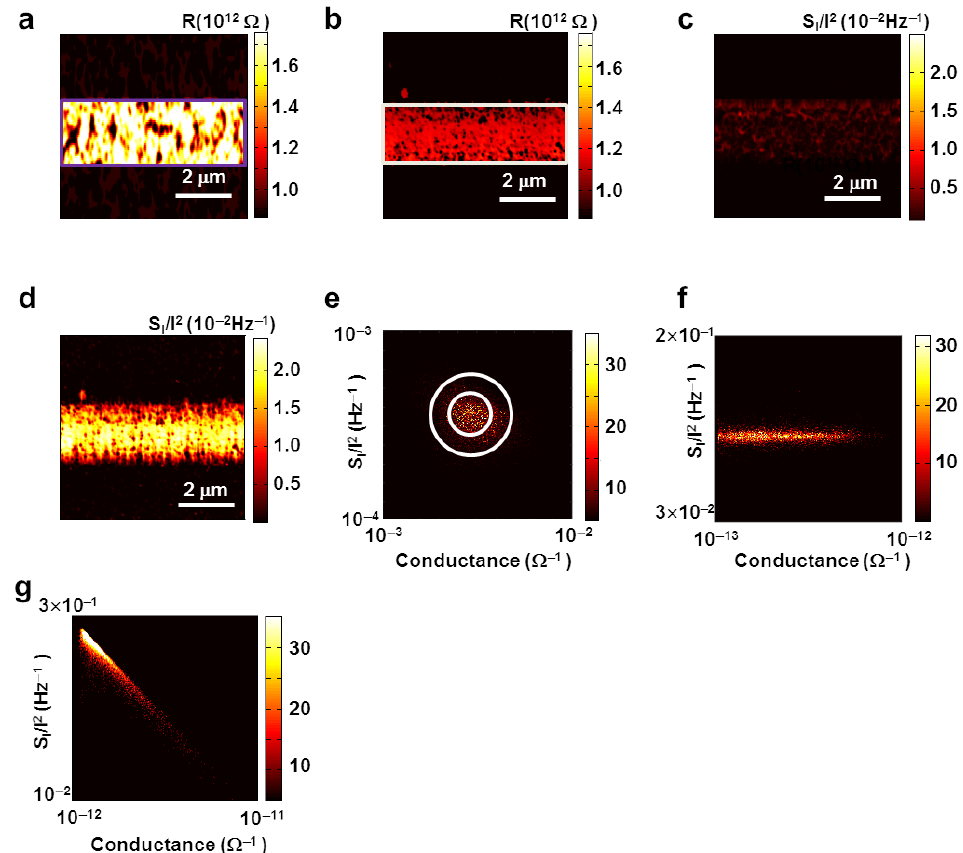
Figure 2. Resistance and noise mapping and their inter-dependence in HSAM and FSAM molecular wire patterns. ( a ) An individual molecular wire resistance map for a HSAM pattern (bright area). The dark area represents bare ITO surface. The order of resistance values on the HSAM regions was of ~T Ω . ( b ) An individual molecular wire resistance map for a FSAM pattern (bright regions) showing ~T Ω of resistance. ( c ) A noise PSD map for HSAM (bright regions). The order of the noise was 10 − 2 Hz − 1 . ( d ) A noise PSD map for FSAM (bright regions) showing a rather large noise with an order of 10 − 1 Hz − 1 . ( e ) A double histogram plot for noise PSD versus conductance on a log-log scale for the ITO. The concentric circular data indicate the typical behavior of a metallic point contact at the junction of the tip and ITO surface. ( f ) A double histogram plot for noise PSD versus conductance on a log-log scale for HSAM. The plot shows that noise PSD was nearly independent of the conductance. This is typical behavior for alkane-chain-based non-polar molecular junctions. ( g ) A double histogram plot for noise PSD versus conductance on a log-log scale for FSAM. Noise PSD scaled as ~ G − 2 implies a tunneling barrier